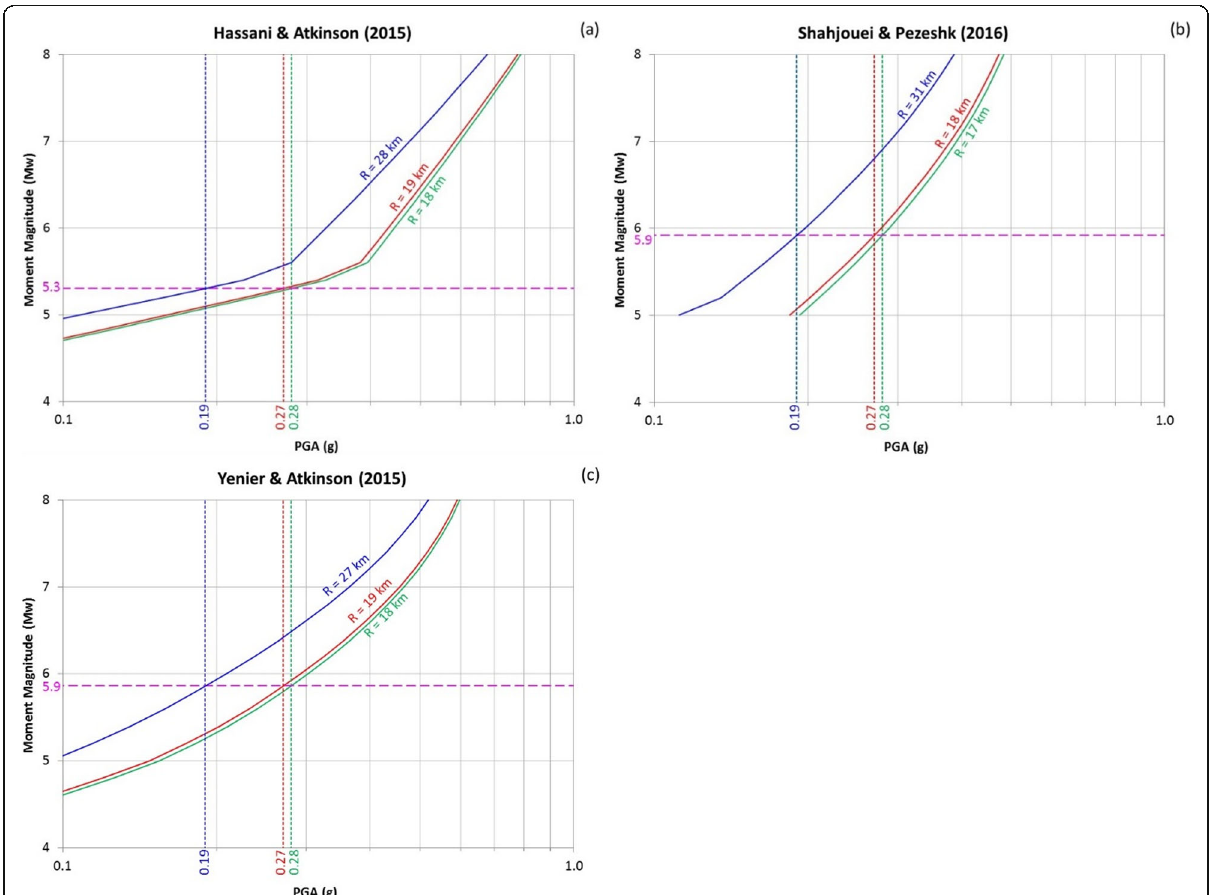
Fig. 9 Relationship between M w and PGA for any given distance from rupture with three Ground-Motion Prediction Equations: (a) HA15, (b) SP16, and (c) YA15. (Magnitudes are rounded to the first decimal point. Epicentral distances are rounded to the nearest